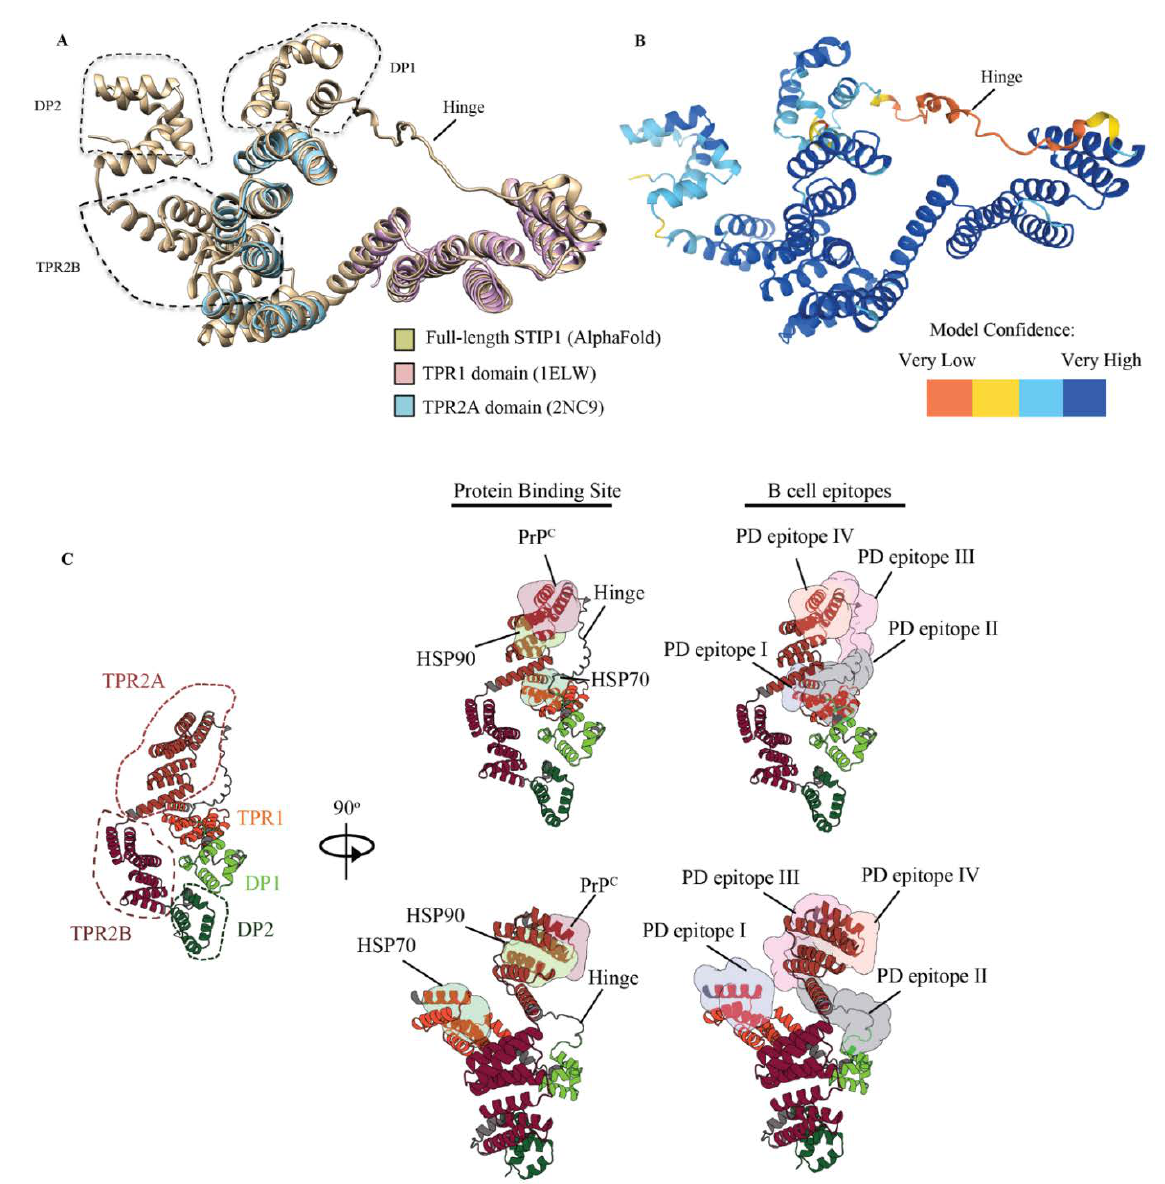
Figure 5. Architecture of the human STIP1 showing canonical protein binding sites and B cell epitopes. ( A ) Structural alignment of human stip1 (AlphaFold) and known high-resolution structures of the human TPR1 and TPR2A domains. The structure shows an overall root mean square deviation of 117 pairs of 0.58Å. Alignment using the X-ray structure PDB ID: 1ELW and nuclear magnetic resonance structure PDB ID: 2NC9 was performed. The molecular analysis was conducted using the UCSF Chimera software [30]. ( B ) The hinge region of the STIP1 protein spanning aa 187 to 217 had a low confidence score, indicating that it may be unstructured in isolation. ( C ) Cartoon representation of the full-length human STIP1 protein predicted using AlphaFold. The protein binding sites of HSP70, HSP90, prion (PrP C ), and the Parkinson’s disease autoantibody epitopes on STIP1 are shown with coloured surfaces according to the labels. Illustrations were drawn with Protein Imager [31].